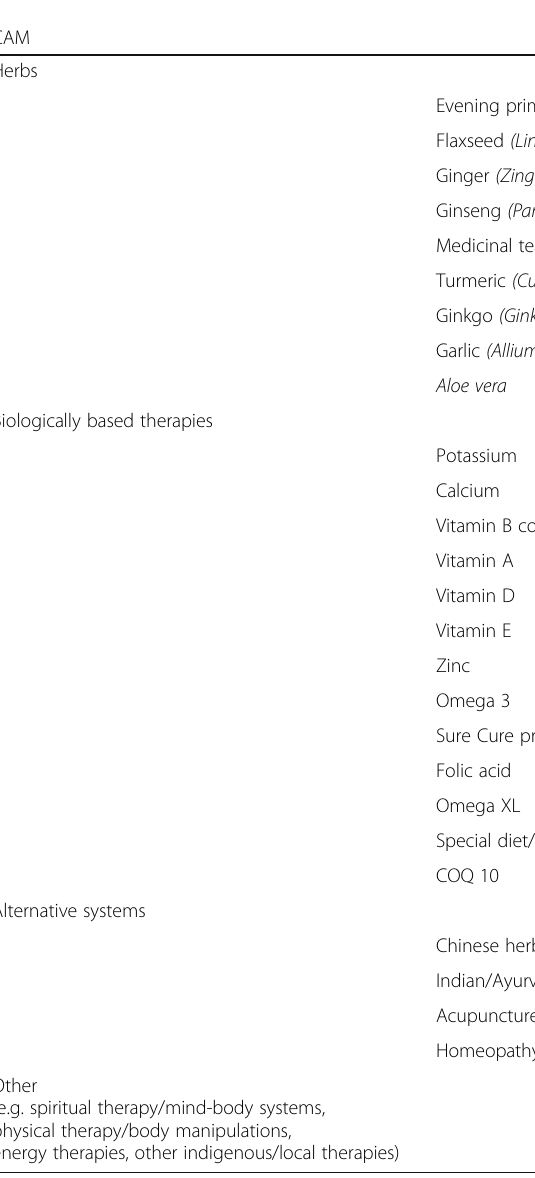
Table 3 Frequency of the use of different types of CAM by kidney patients Use pattern, n (%) CAM Used in past Used presently Will use in the future Herbs Evening primrose (Oenothera)